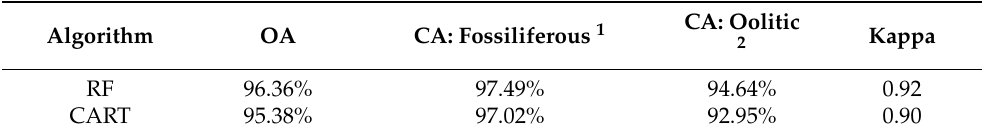
Table 6. CART and random forest (RF) overall and consumer accuracies (OA and CA) and kappa coefficient for limestone formations classification with masking Landsat-8